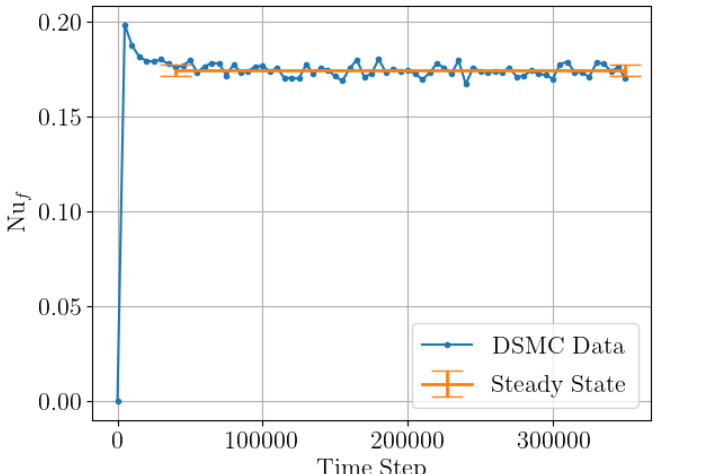
Figure 1. Typical time dependent result for wire heat transfer for hotwire direct simulation Monte Carlo (DSMC) simulations. The solid orange line shows the average of the steady-state data and ± 1 σ . It should be noted that the dump frequency will not change the calculated average of the steady-state data, only the scatter of those data (visualized by σ ). This is because each output data point represents the average of an equal number of per-time-step data points. An average of the averaged per-time-step data will be equal to the average of the original set of data. DSMC results throughout this study are presented as a point with error bars. The point represents the average of the steady-state data, and the error bars indicate ± 1 σ of the output